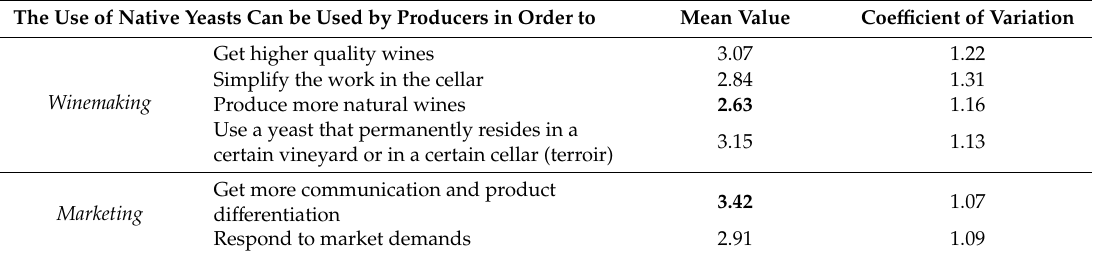
Table 3. Mean values and coe ffi cients of variation related to the use of indigenous yeast.